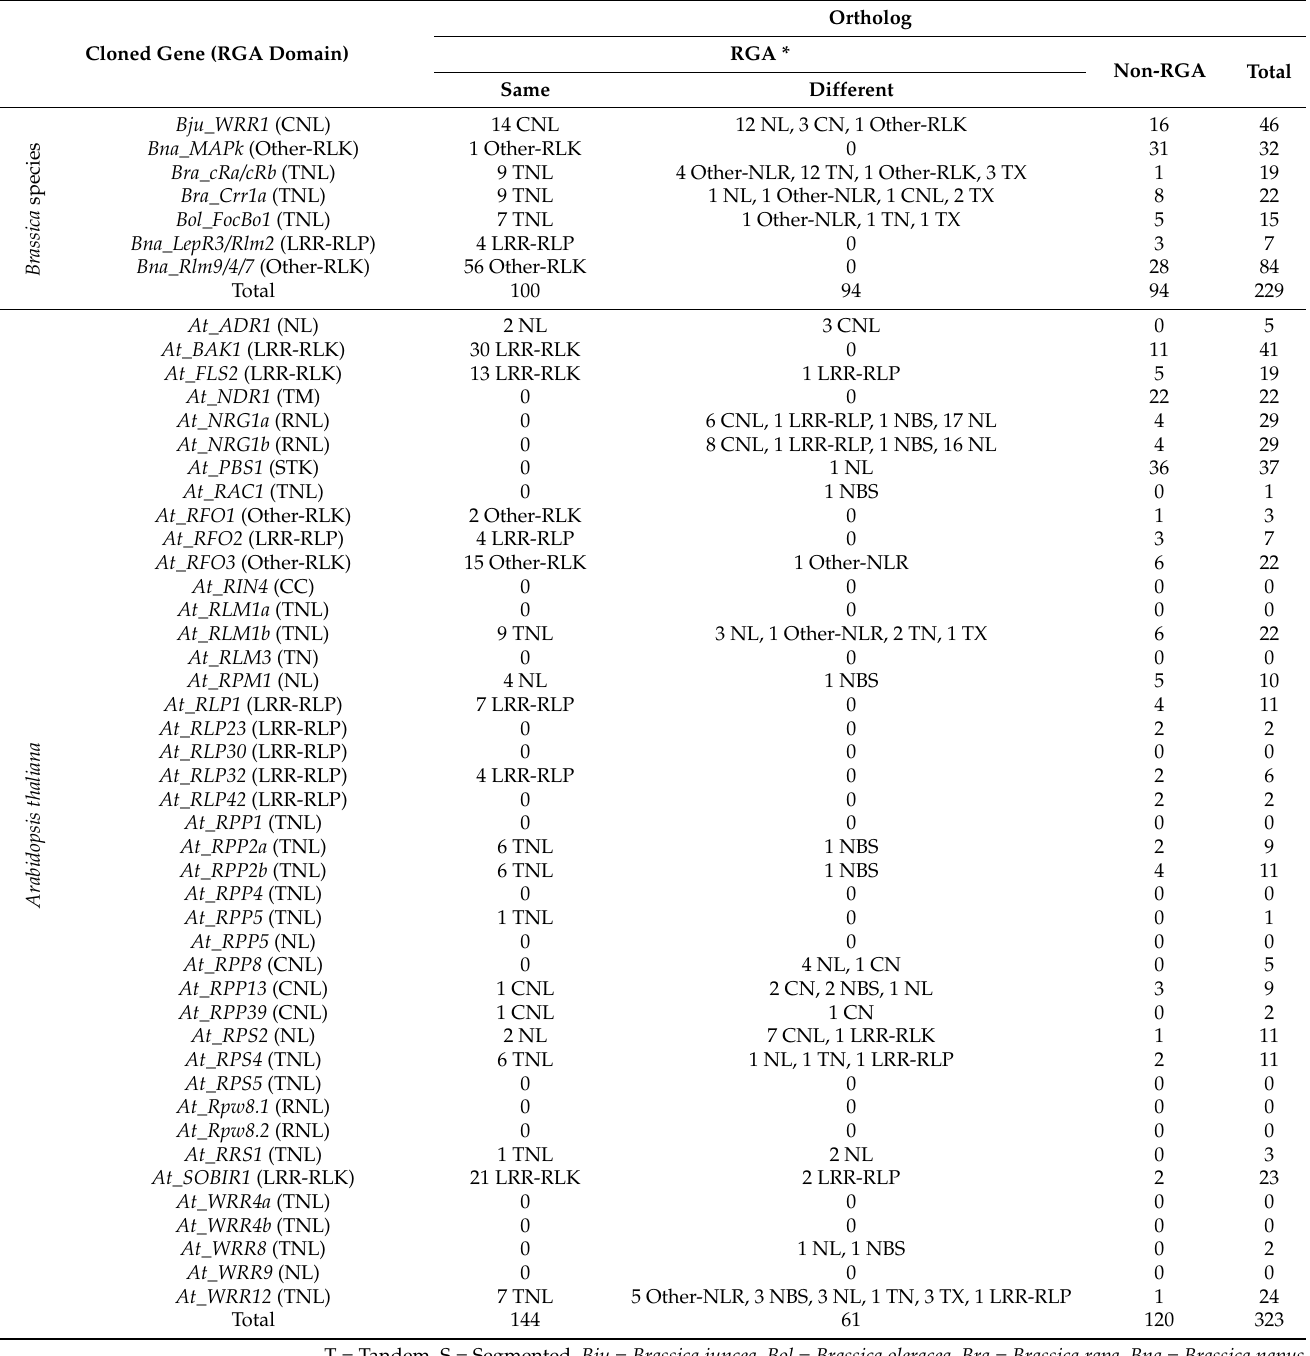
Table 4. Cloned genes in Brassica crops and Arabidopsis thaliana and their corresponding orthologs (cloned disease R gene homolog